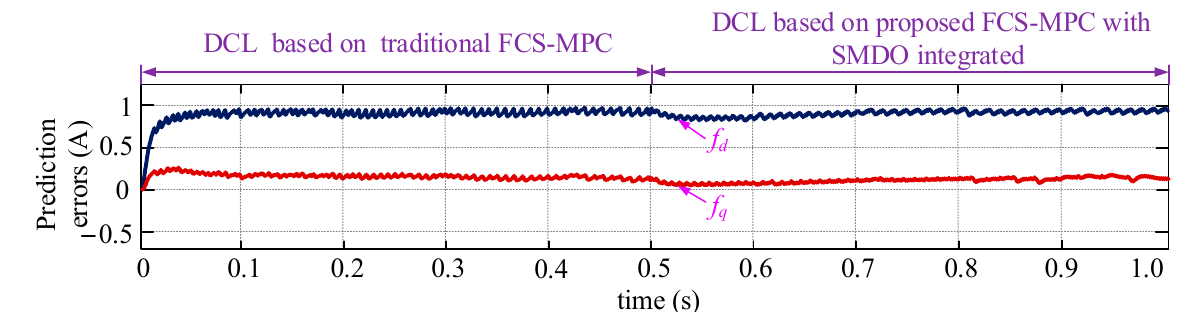
Figure 11. Control performance of the proposed DCL method with parameter mismatch considered (the SMDO works, L f_mea = 0.2 L f , L l_mea = 0.2 L l , R f_mea = 2 R f , R l_mea = 2 R l ).